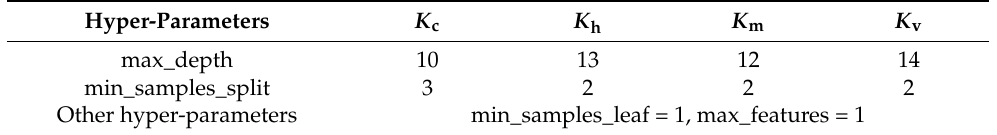
Table 4. The optimal DT hyper-parameters after PSO tuning.